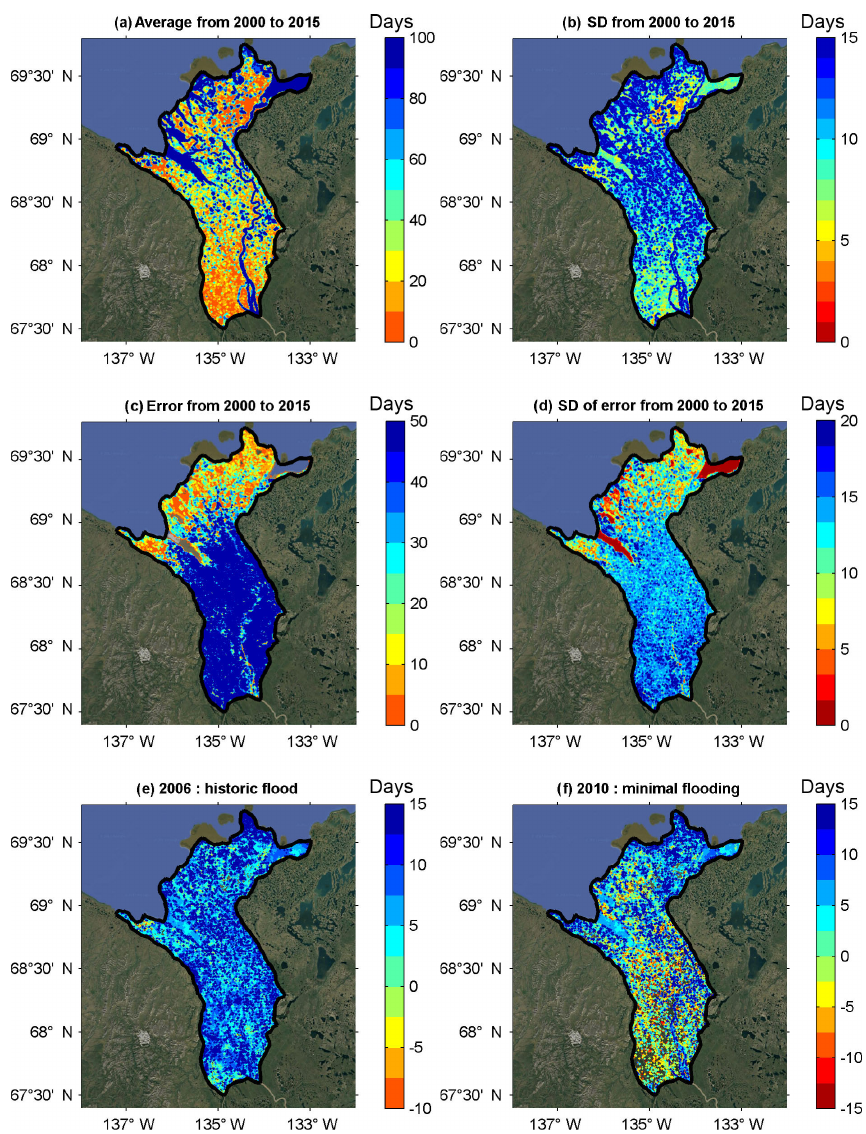
Figure 3. Maps of surface water extent duration for (a) annual average from 2000 to 2015, (b) annual standard deviation from 2000 to 2015, (c) error average from 2000 to 2015, (d) standard deviation from 2000 to 2015, difference between annual average water surface area duration from 2000 to 2015 and water surface area duration during (e) 2006, the period associated with the highest flood event, and (f) 2010, the period associated with the lowest flood event recorded over the